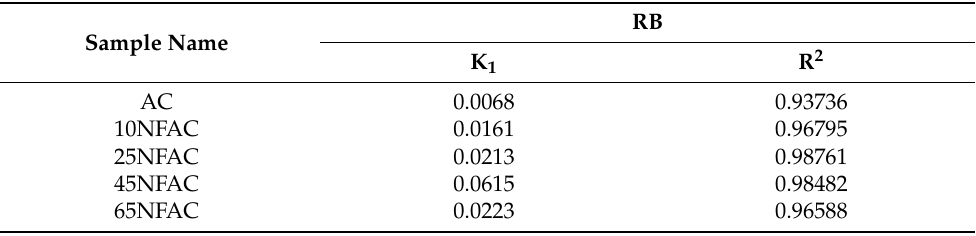
Table 2. Correlation coefficients and rate constants for rhodamine B photodegradation.